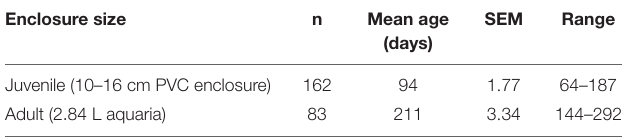
TABLE 1 | Mean age of O. chierchiae when moved to larger